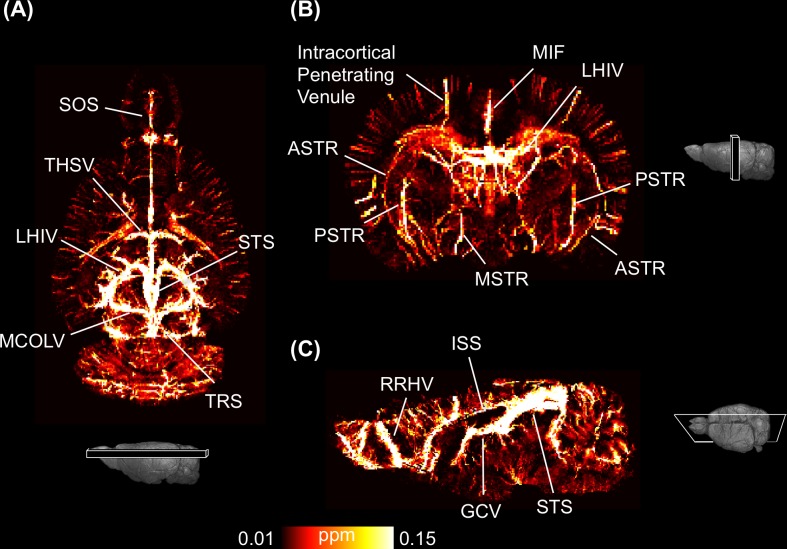
Quantitative visualization of QSM of a normal rat brain in three orthogonal views.Veins in the cortical and internal brain are indicated. (A) A 2.5-mm-thick maximum intensity projection (MIP) in coronal view, (B) axial view, and (C) sagittal view. The major veins are labeled, including the great cerebral vein (GCV) of Galen, intracortical penetrating venule, inferior sagittal sinus (ISS), longitudinal hippocampal vein (LHIV), medial collicular vein (MCOLV), superior olfactory sinus (SOS), superior sagittal sinus (SSS), straight sinus (STS), thalamostriate vein (THSV), transverse sinus (TRS), middle internal frontal vein (MIF), anterior striate vein (ASTR), posterior striate vein (PSTR), medial striate vein (MSTR), and rostral rhinal vein (RRHV).